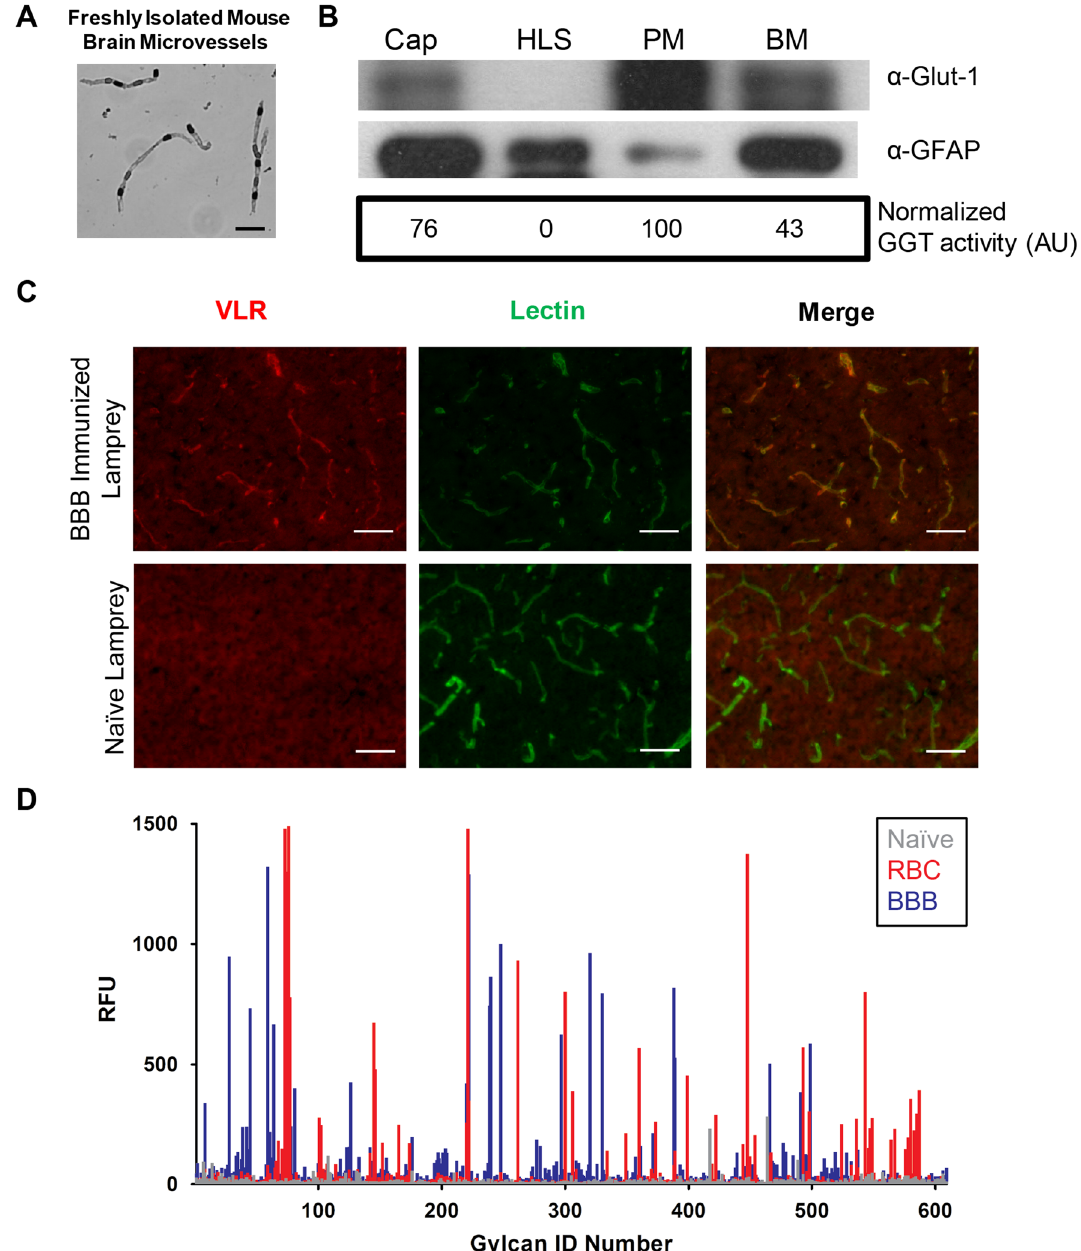
Figure 1. Brain microvessel plasma membrane (BMPM) isolation and lamprey immunization validation. ( A ) Isolated mouse brain microvessels were stained with trypan blue. Scale bar = 25 μm. ( B ) Cropped western blots for Glut-1 and GFAP along with normalized GGT activity for the various fractions generated during BMPM isolation. Raw western blot data can be found in Fig. S11. Hypotonic lysis was used to disrupt the isolated brain microvessels. Following centrifugation, the supernatant (HLS) was separated from the lysed microvessel fragments. Sonication of the microvessel fragments and centrifugation separated the plasma membranes (PM) from the basement membrane pellet (BM). ( C ) Pooled plasma from BBB immunized lampreys or a plasma sample from a naïve lamprey were used to immunolabel mouse brain sections (red) and brains were counterstained with fluorescent IB 4 -lectin (green) to identify brain microvessels. Scale bar = 50 μm. ( D ) Glycan microarray analysis. Plasma samples from a naïve lamprey (Naïve, gray), lamprey immunized with human erythrocytes (RBC, blue), or BMPM immunized lamprey (BBB, red) were used to probe the CFGv5.2 glycan microarray. RFU = relative fluorescence